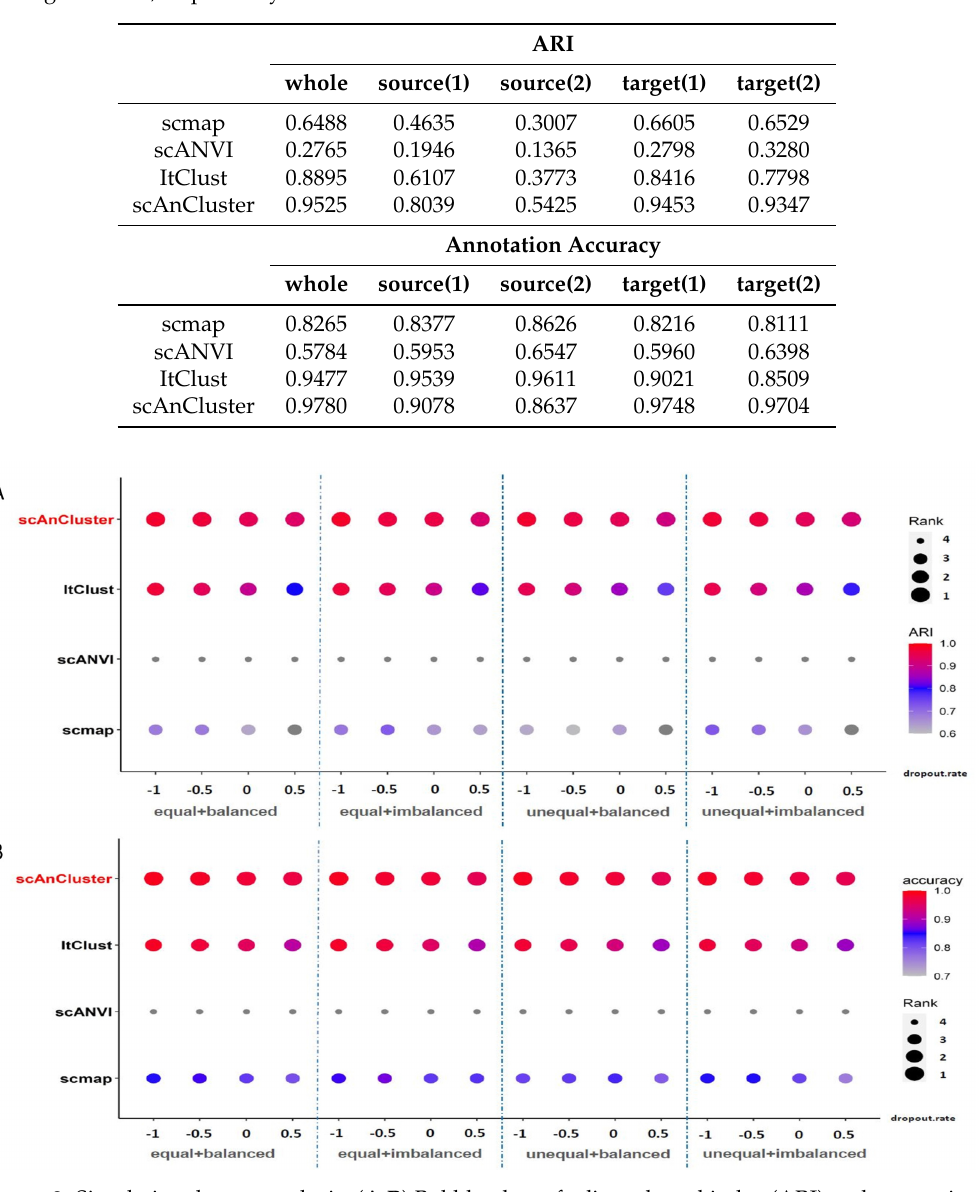
Figure 2. Simulation dataset analysis. ( A , B ) Bubble plots of adjusted rand index (ARI) and annotation accuracy values for four methods in sixteen groups of simulation experiments using the whole mixed datasets,